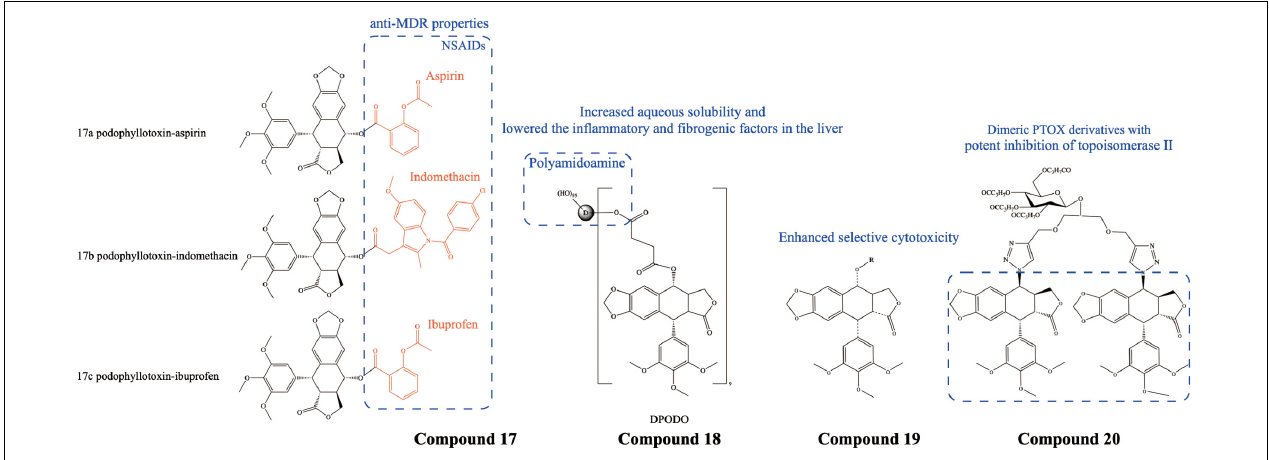
FIGURE 5 | Chemical structures and therapeutic highlights of PTOX derivatives Compound